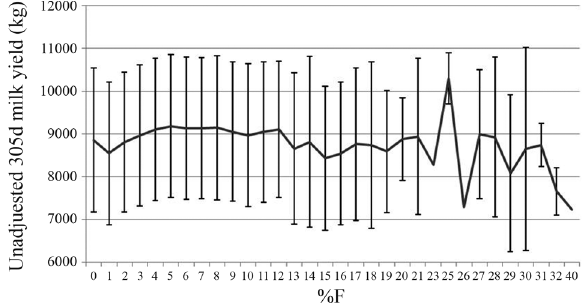
Figure 1 - Unadjusted average 305 d milk yield (kg) with values within 1 standard deviation by inbreeding coefficient